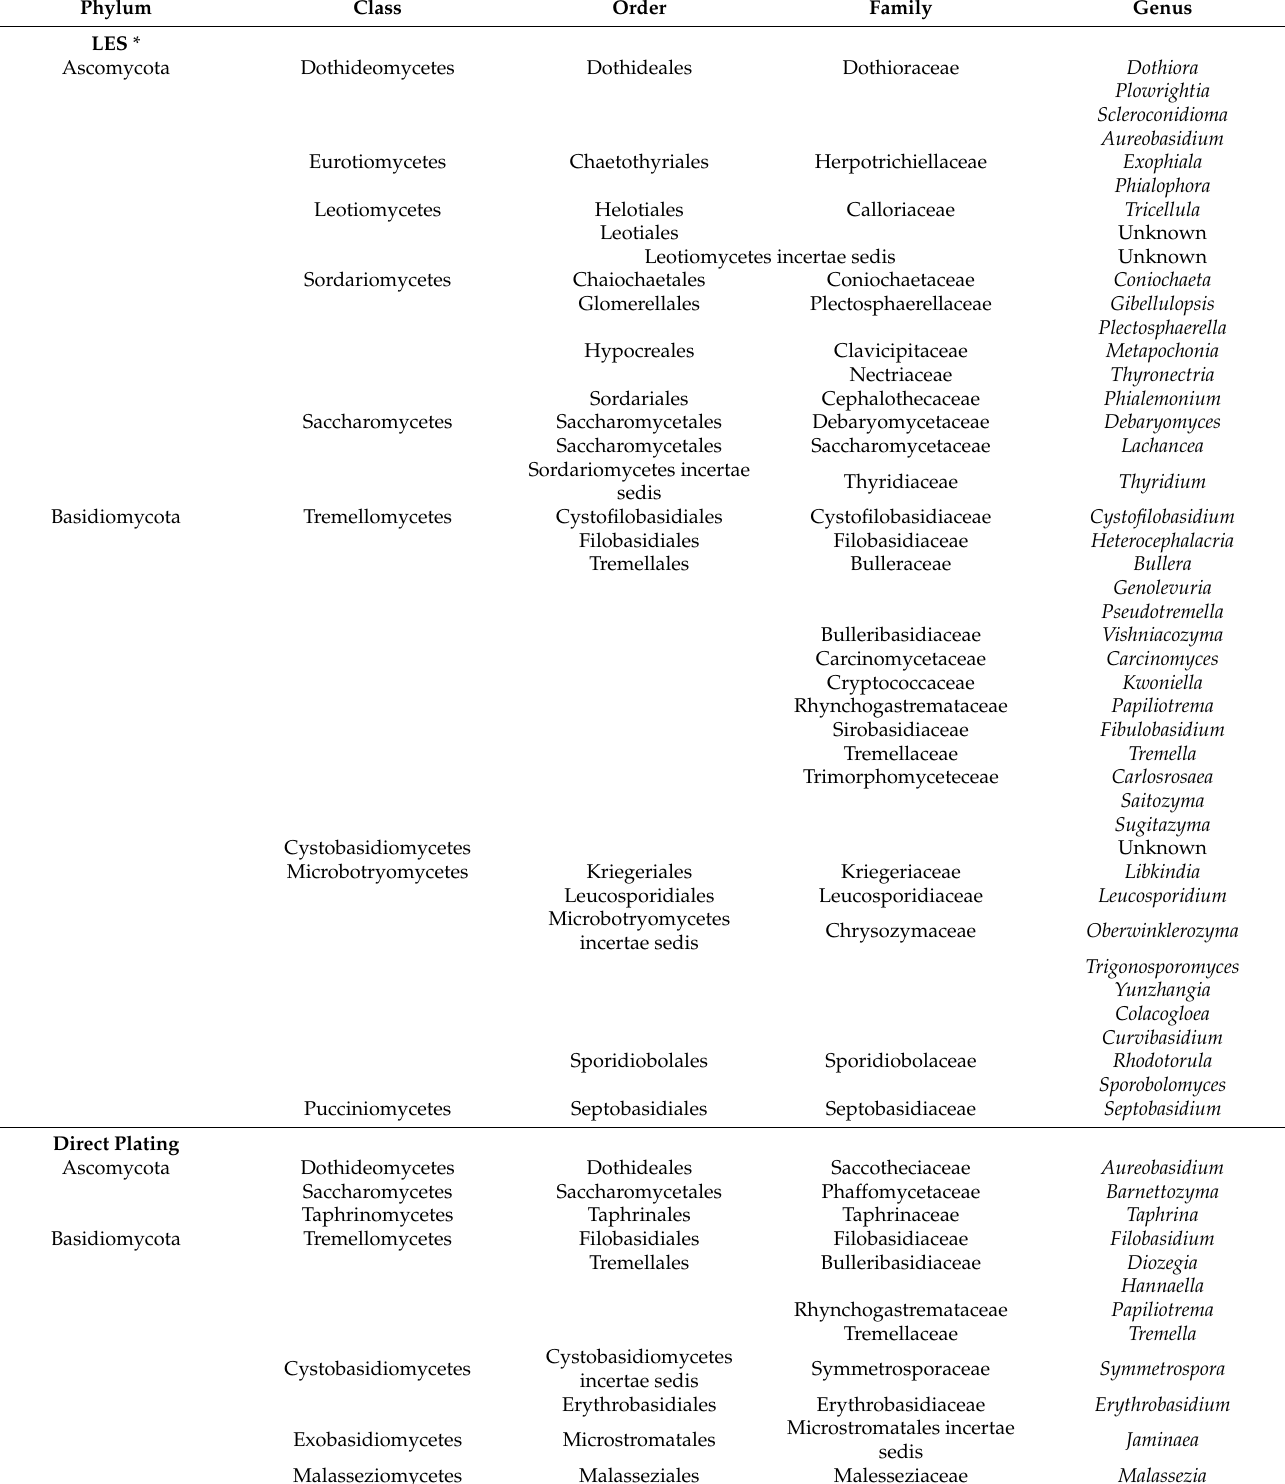
Table 2. Generic diversity of culturable lichen-associated yeasts using liquid enrichment and selective strategies and direct